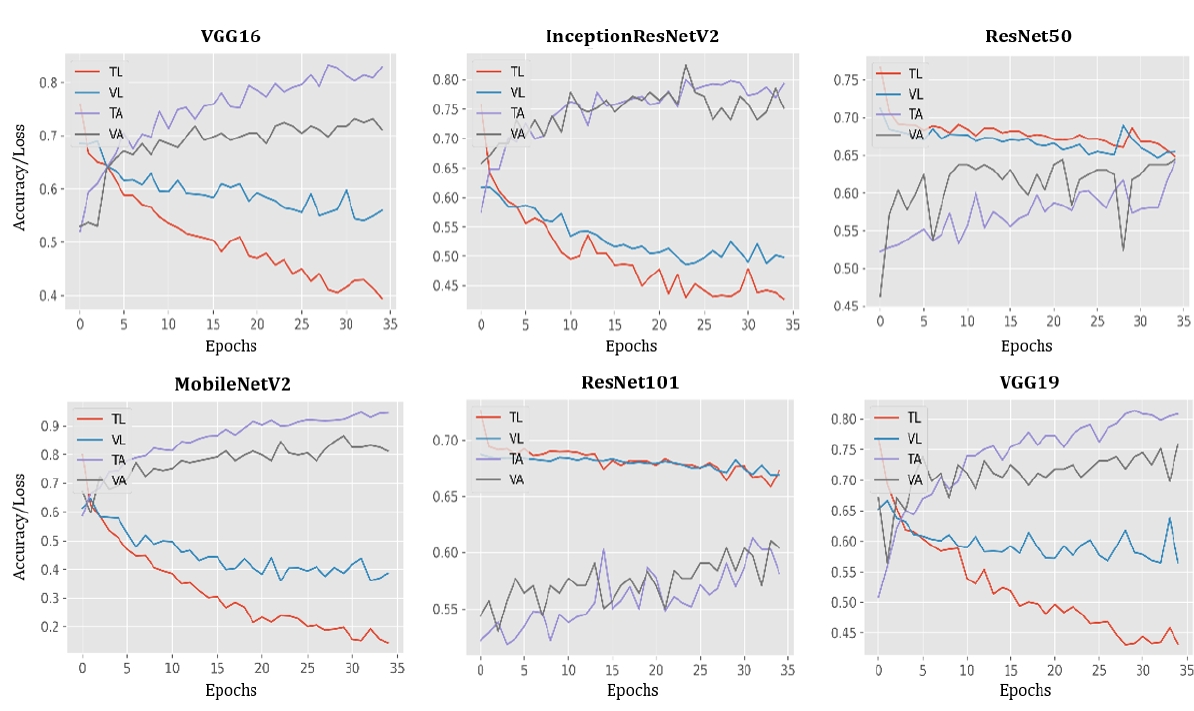
Figure 5. Plots of model accuracy and loss following each epoch applied to both training and testing datasets; TL = training loss; VL = validation loss; TA = training accuracy; VA = validation accuracy.